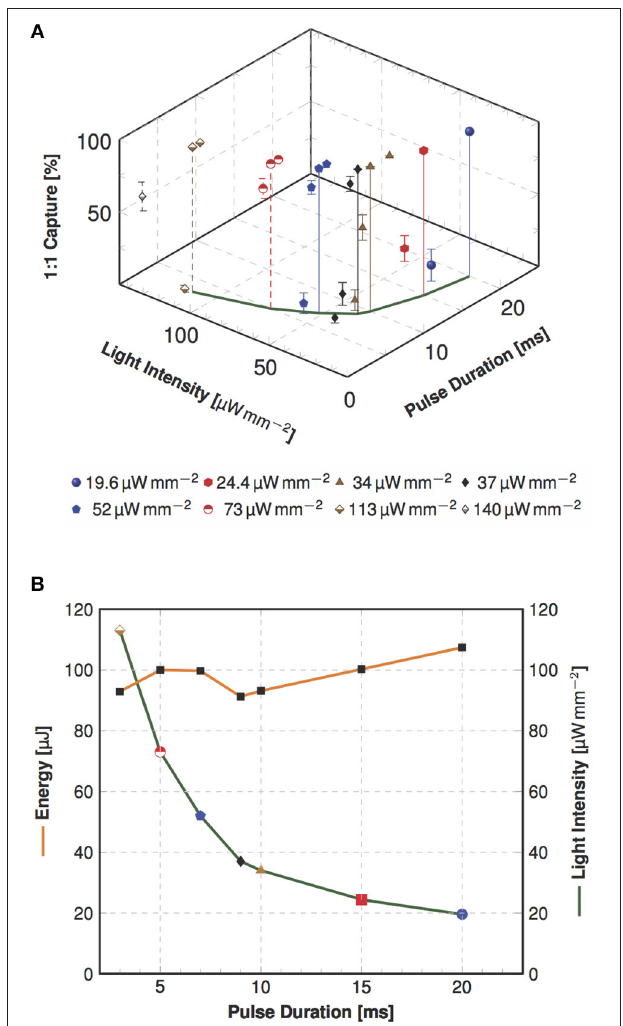
FIGURE 2 | Dependency of pulse duration and light intensity as well as pulse energy in global optogenetic pacing. (A) The three-dimensional plot illustrates the averaged success rate ± SEM of 1:1 capture in dependency of investigated combinations of light intensity and pulse duration (as indicated in Table 1 ). In this view the variation of measured capture rates is clearly visible, but still approving the dependency of successful 1:1 capture of light intensity and pulse duration. In the x-y section are the most efficient combinations marked, which is visualized in a plain view in the next panel. (B) Shown are the most efficient combinations of required light intensity and energy for different pulse duration values ( N = 6). The analysis shows a nearly constant energy, but an increase in intensity when the pulse duration is shortened.